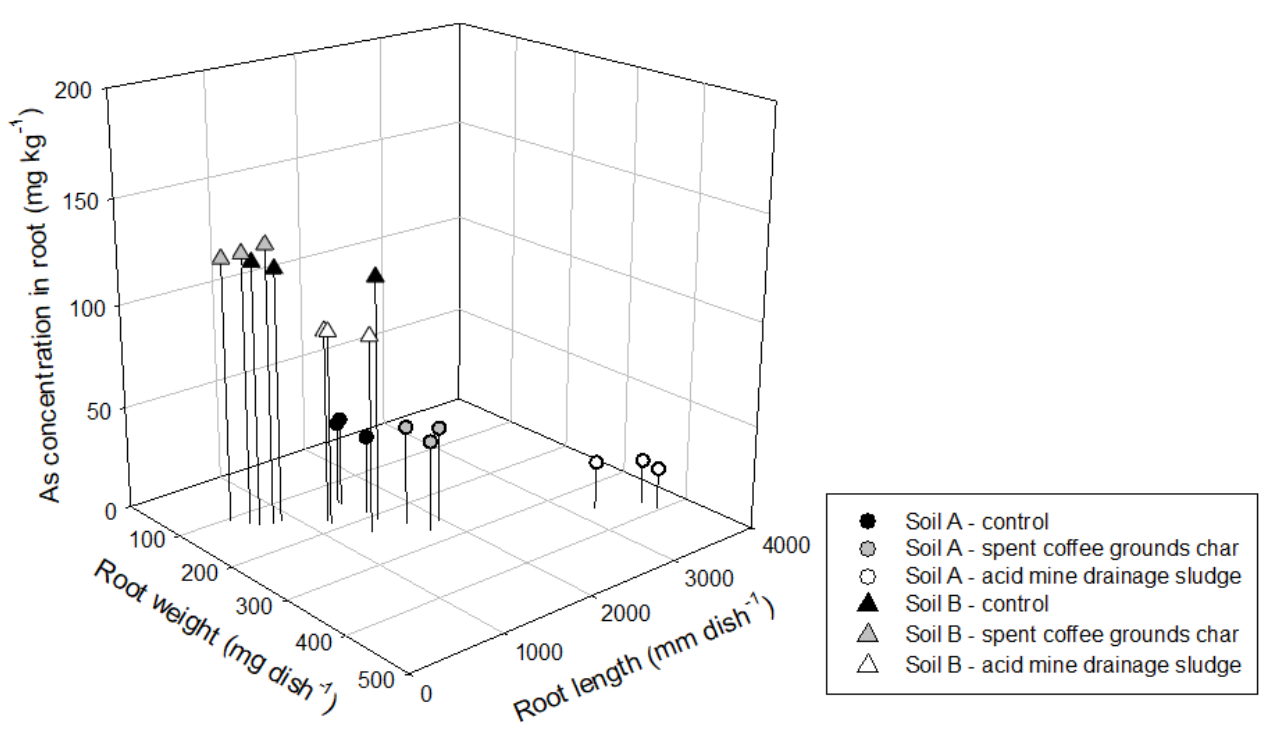
Figure 1. Distribution of weight, length, and As concentration in lettuce root after 4 weeks cultivation.